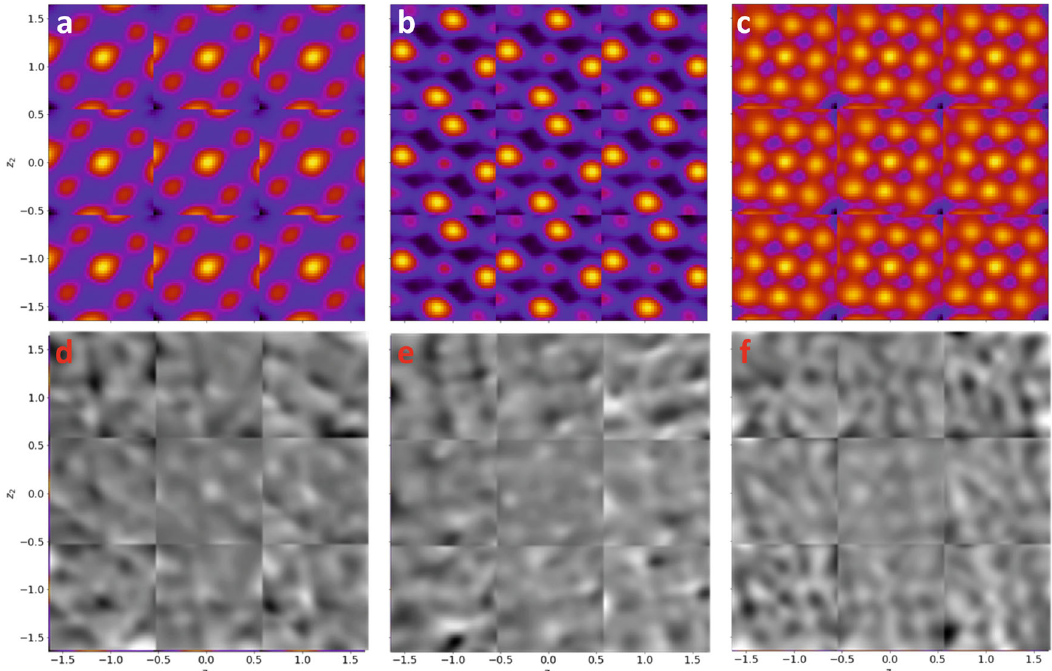
Fig. 5 Application of conditional rVAE to the (La x Sr 1-x )MnO 3 – NiO system. Conditional rVAE analysis of the three GMM components from Fig. 4 corresponding to the a , d A-site (component 1), b , e B-site (component 2) columns of the LSMO phase and c , f NiO phase (component 3). The upper images are the raw images, and the lower images have the average of the 3×3 tableau The analysis is repeated on the DCNN segmented image shown in Fig. S6. In this case components 1 and 3 correspond to the LSMO lattice and component 2 corresponds to the NiO phase.